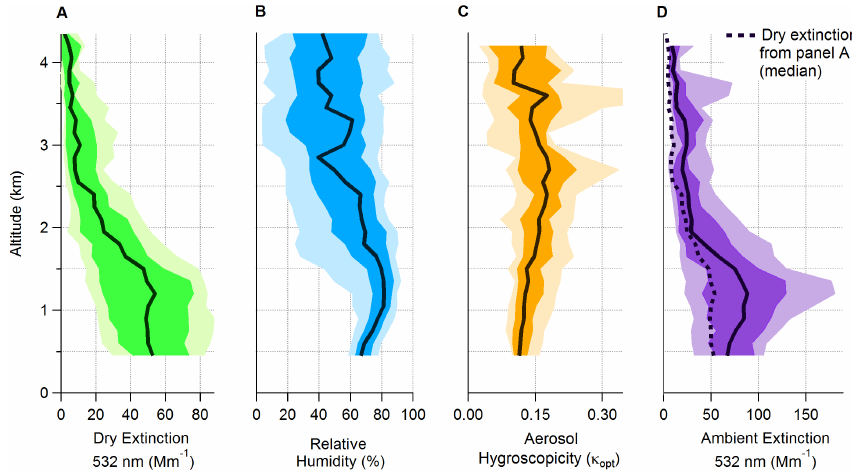
Figure 3. Altitude-binned aggregate profiles of (a) the 532nm dry aerosol extinction, (b) relative humidity (calculated from dew point measurements), (c) aerosol hygroscopicity (humidified extinction measurements fit to Eq. 1), and (d) the calculated ambient extinction (Eq. 1). The shaded regions show the interdecile range (light) and the interquartile range (medium), and the solid lines are the median (dark). The dashed line in (d) shows the median dry extinction for comparison.